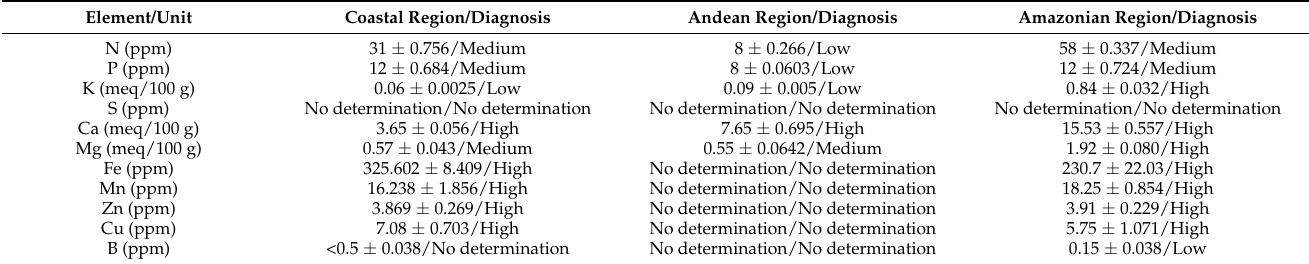
Table 1. Abiotic components from the studied regions in agreement with soil analysis.